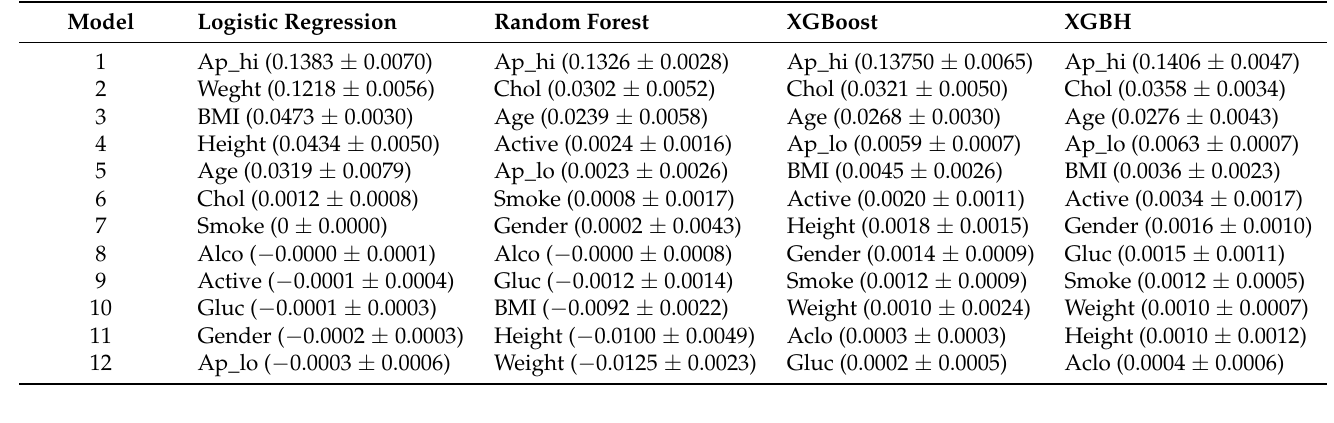
Table 3. Feature importance of each prediction.